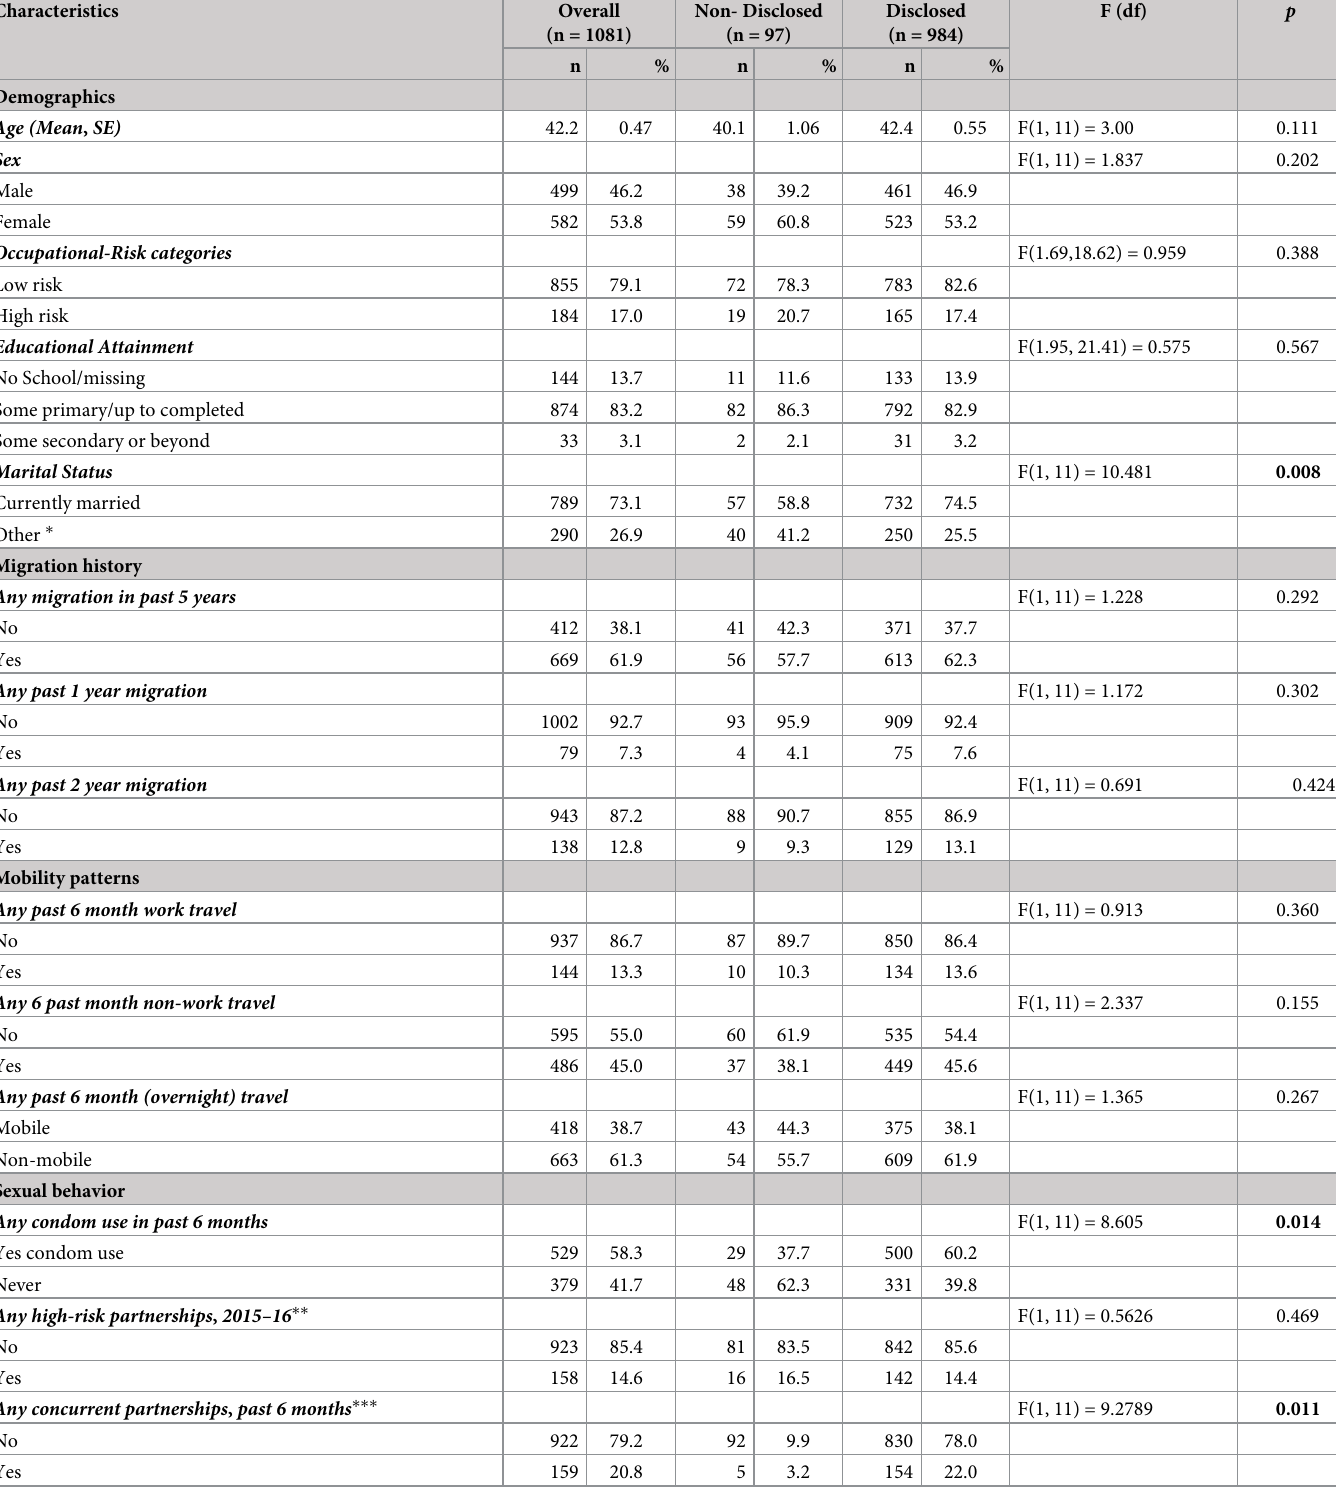
Table 1. Characteristics of adults who had and had not disclosed HIV-positive status at baseline, adjusted for community clustering.